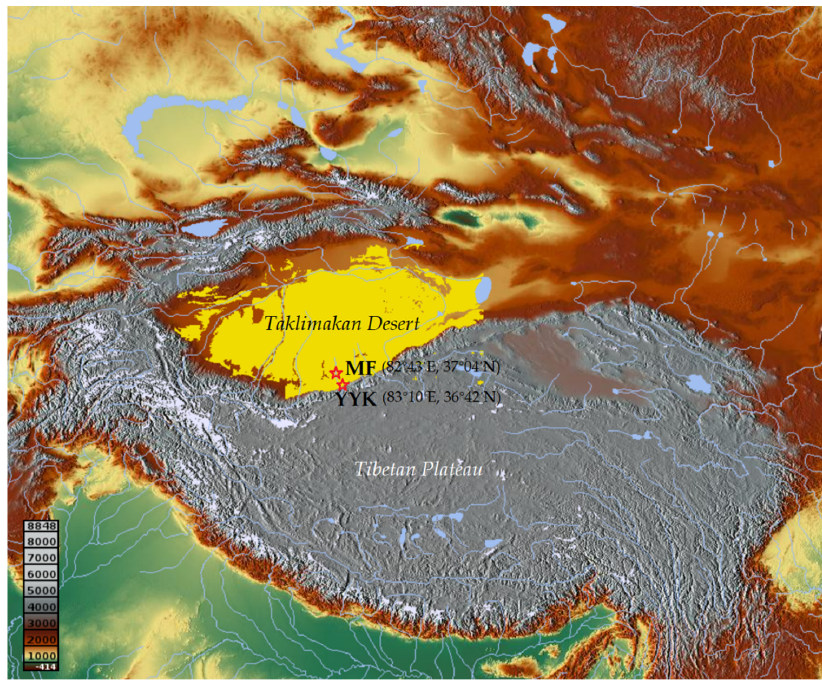
Figure 1. Location map of field experiment station at northern edge of Tibetan plateau.